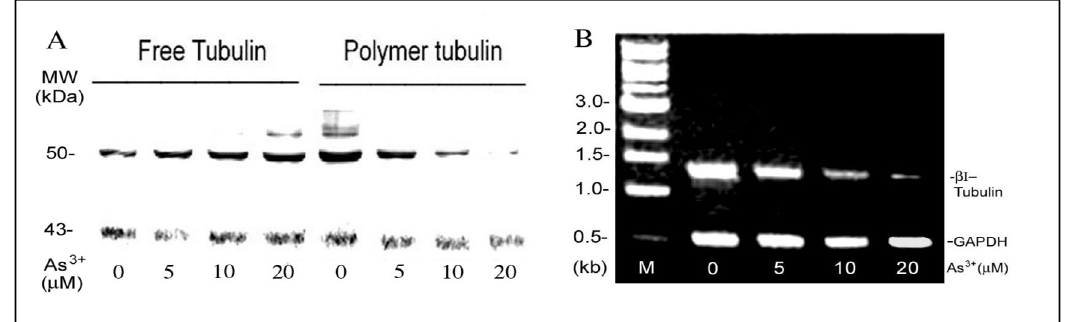
Figure 3. As 3+ effects on expressions of tubulin proteins and mRNAs in the cell model. ( A ) As 3+ enhanced the free tubulin pool as a result of depolymerization of MTs. Growth-arrested RFL6 cells were treated with As 3+ at indicated concentrations for 24 h. Cytoskeletal and cytosolic fractions were isolated, and analyzed by Western blot. β -tubulin, 50 kDa; actin, 43 kDa used as a reference. ( B ) As 3+ inhibition of steady-state β I tubulin mRNA levels. Cells were treated with As 3+ as indicated above. Total RNA extracted was assessed for steady-state β I tubulin mRNA levels by the RT-PCR. GAPDH mRNA levels were used as an internal control. M indicates a DNA molecular